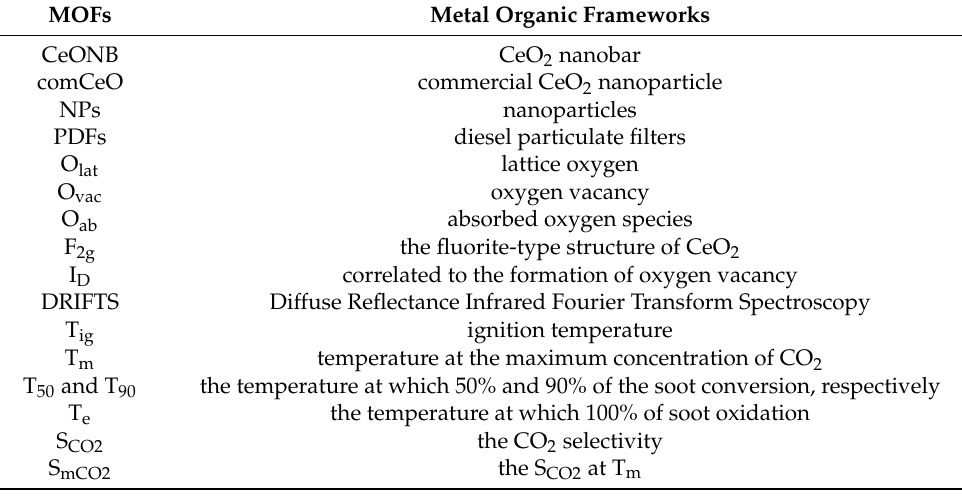
Table 4. The list of acronyms and